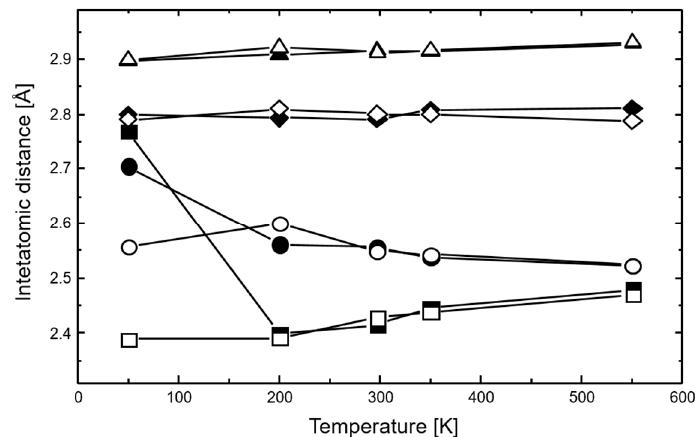
Figure 7. Magnetic moments in Mn 1.8 Co 0.2 Sb at different temperatures. Green, dark blue/red, and light blue symbols stand for Sb, Mn1/Co1, and Mn2, respectively.